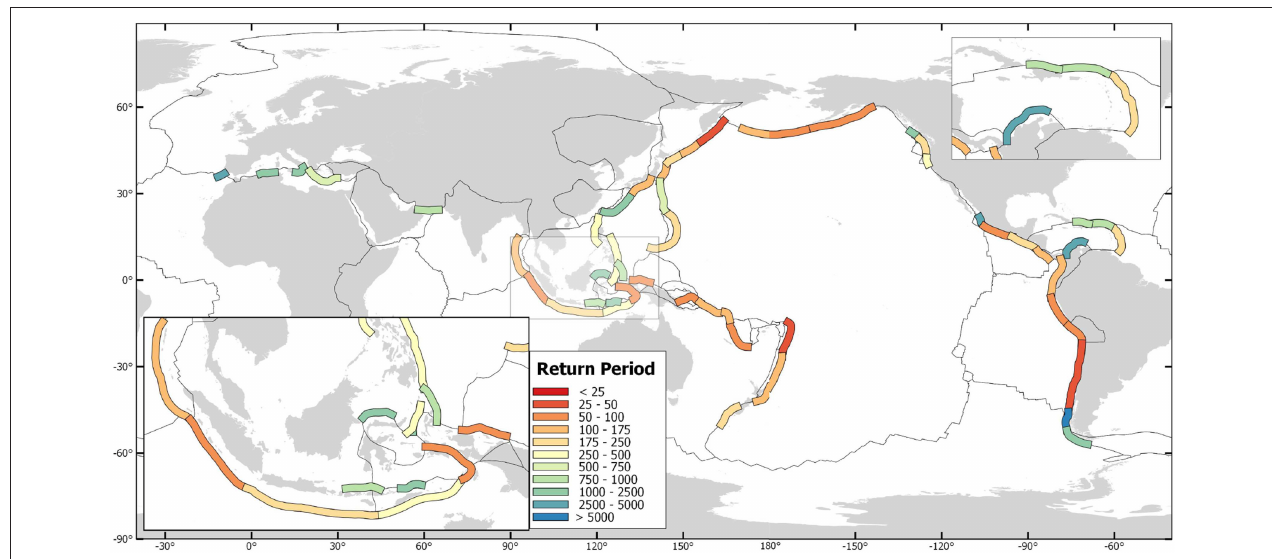
FIGURE 6 | Map of average expected return periods in years of earthquakes of M w ≥